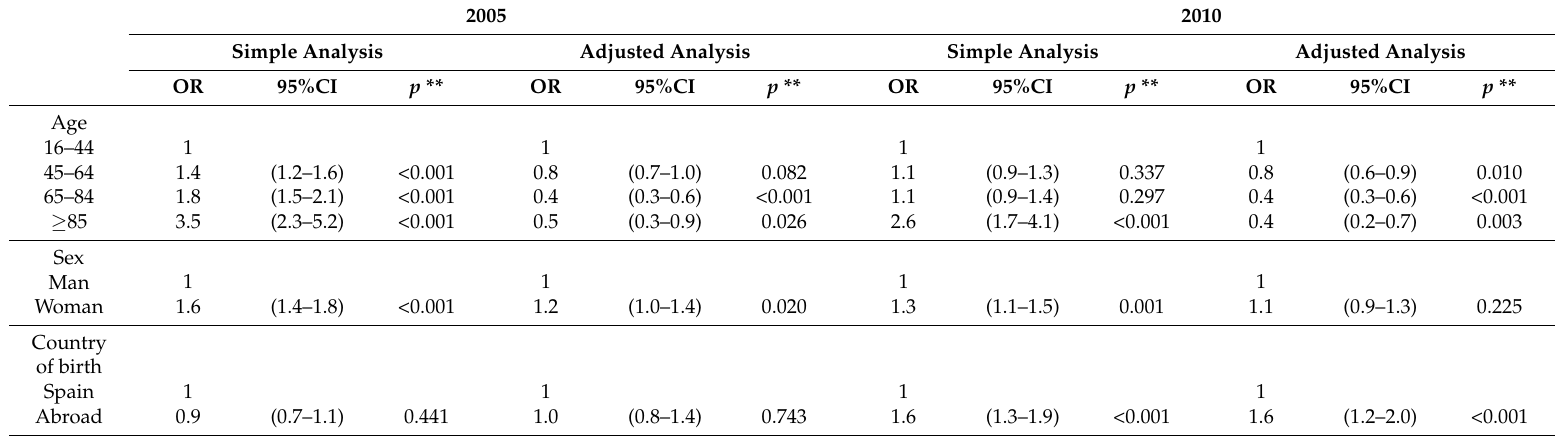
Table 4. Odds ratios (OR) and 95% confidence intervals (95%CI) of association between the risk of poor mental health (GHQ+) and the variables studied